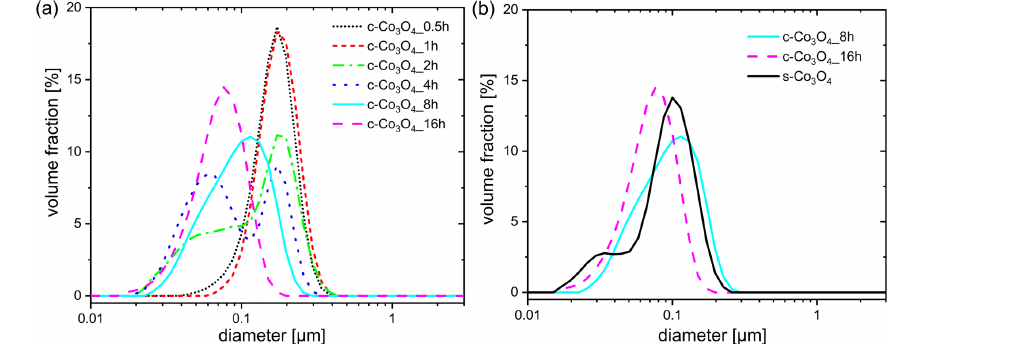
Figure 1. Differential volume distribution of particle sizes obtained for (a) commercial Co 3 O 4 samples ground for different durations and (b) two Co 3 O 4 samples ground for 8 and 16h in comparison to the synthesized Co 3 O 4 sample.